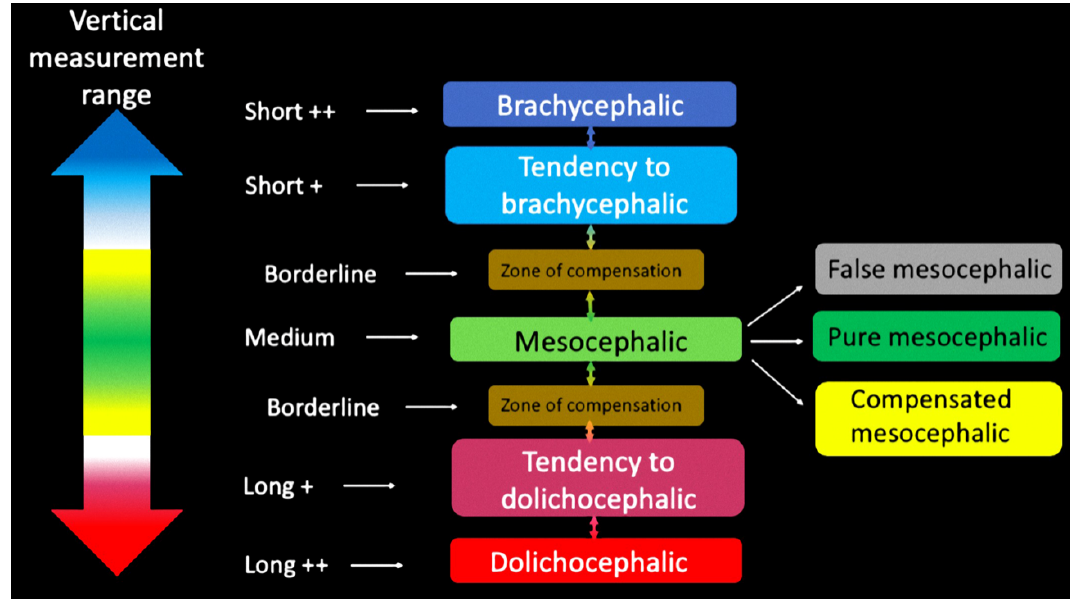
Figure 3. Diagram showing intervals of values associated with a given color which, in turn, indicates a particular diagnosis.